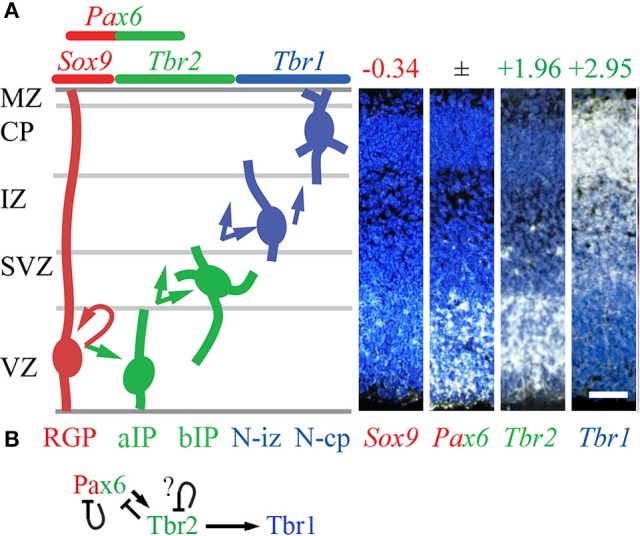
Cell types, TF expression, and histological zones in E14.5 mouse neocortex. (A) Neurogenesis and cell-type-specific TF expression. Histological zones and cell types (left) are aligned with TF gene ISH (right; white ISH signal, blue nuclear counterstain). Arrows indicate common (but not exclusive) pathways of neurogenesis. Numbers above ISH panels indicate log2FC on Tbr2-GFP microarray (all p < 0.05). Abbreviations: see text. ISH: Allen Brain Atlas Developing Mouse Brain, E15.5 (colors inverted for figure). Scale bar: 50 μm. (B) The Pax6→ Tbr2→ Tbr1 cascade involves direct feedforward activation (arrows) and feedback repression (bars). The effect of Tbr2 binding at the Tbr2 locus could not be determined from available data (see text), but could be feedback repression.